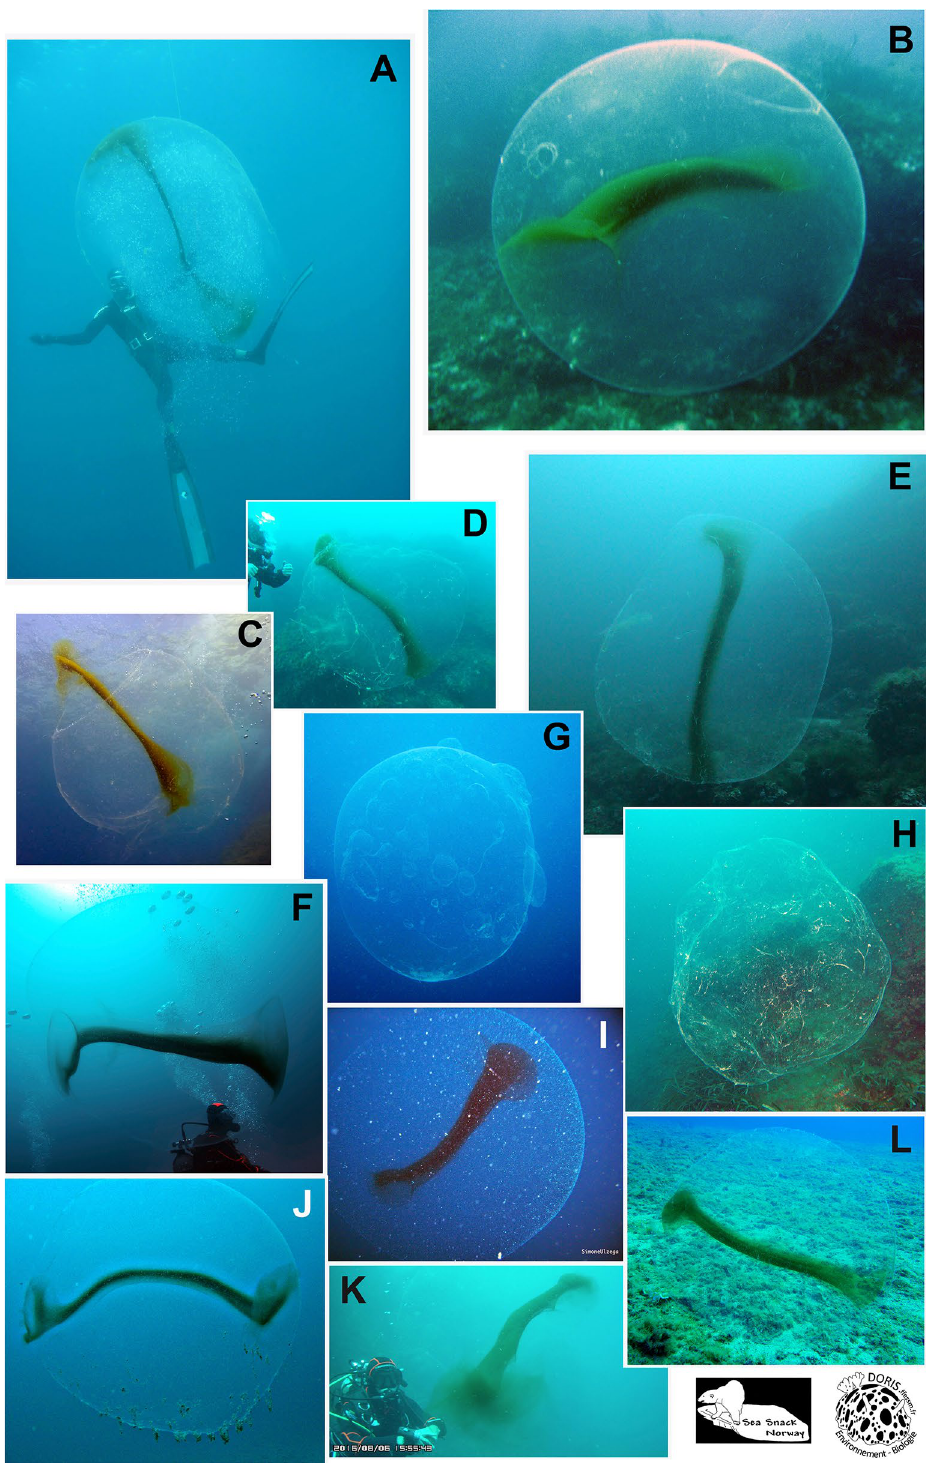
Figure 5. Huge gelatinous spheres from the Mediterranean Sea and the Spanish Atlantic coast, attributed to squid egg mass. (Photo credits: ( A ) Franc Jourdan, ( B ) Thomas Brelet, ( C ) Edouard Bard, ( D ) Eduardo Losada Lage, ( E ) José Coronel, ( F ), Philippe Le Roy, ( G ) Christine Chesnay, ( H ) Pietro Crovetto, ( I ) Simone Ulzega, ( J ) Alain Beauté, ( K ) Patrick Carreno, ( L ) Emmanuel Roguet. Collage by Halldis Ringvold/Sea Snack